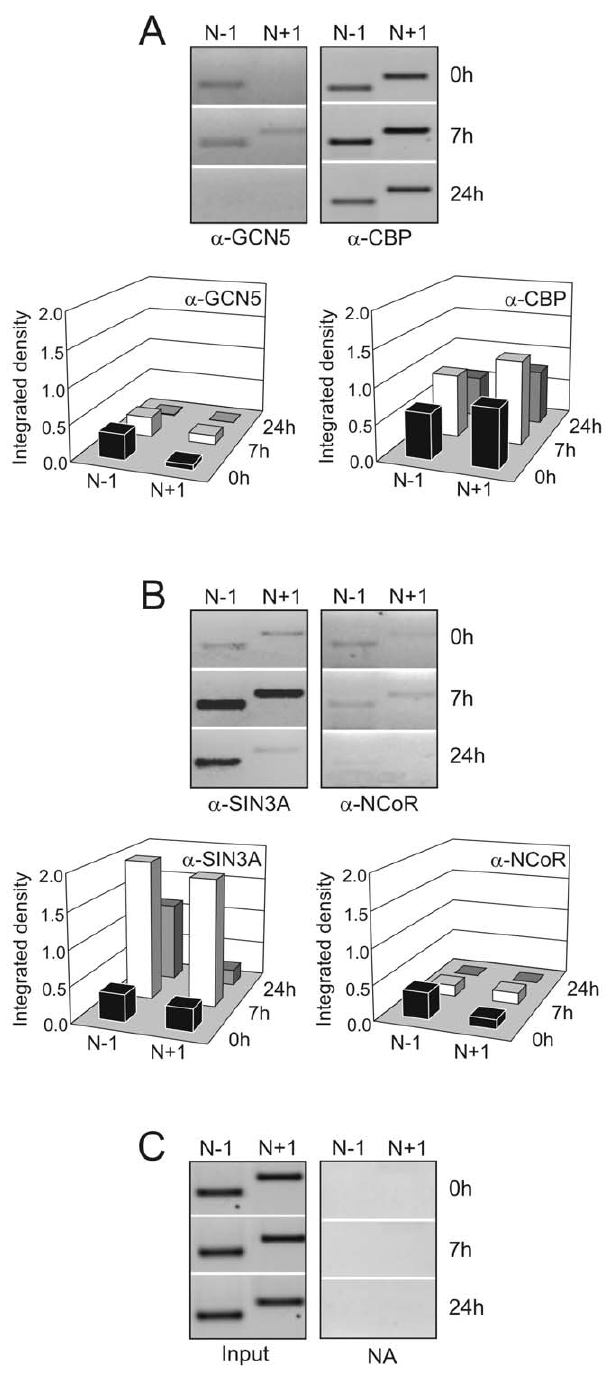
Figure 4. Nuc-ChIP assay of the chromatin modifying com- plexes recruitment to Gas1 TSS vicinity after PH. (A) histone acetyltransferase (GCN5-containing and CBP-containing) and (B) histone deacetylase (Sin3A-containing and NCoR-containing) complexes. (C) Input and non-antibody (NA) samples used to subtract the background and to normalize PCR band signals as described in figure 3.The images are representative of at least three independent experiments.